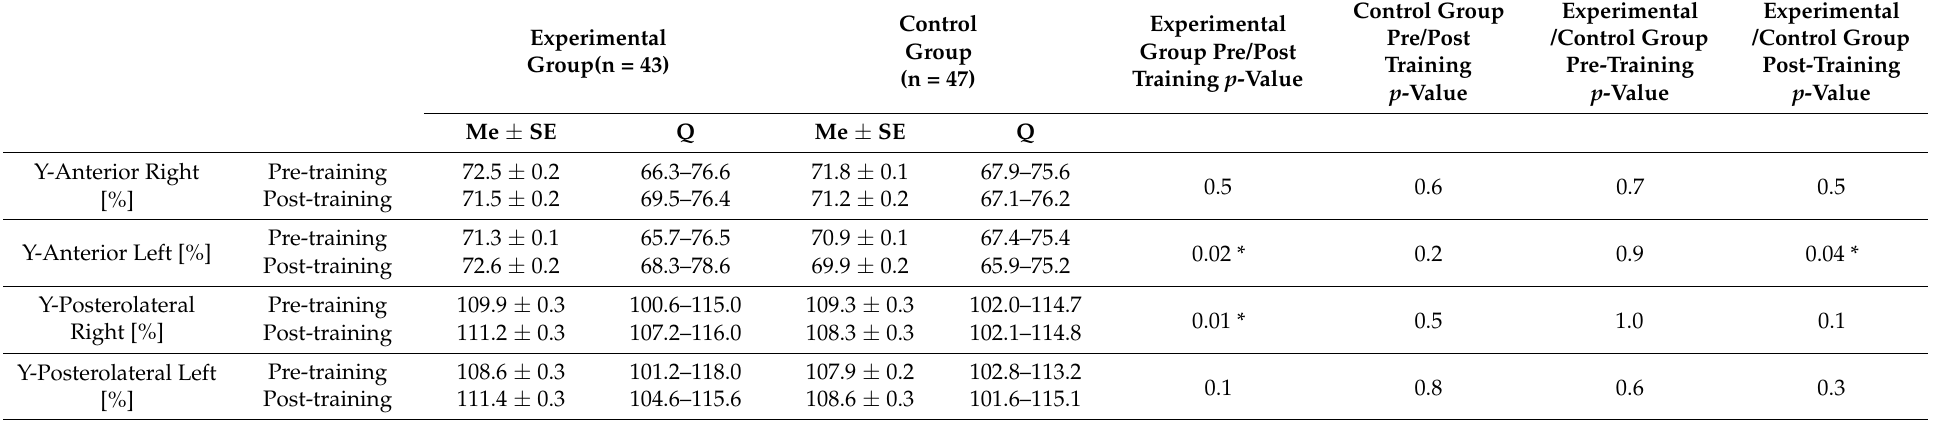
Table 3. Effect of a 10-week sensorimotor exercise program on the results of